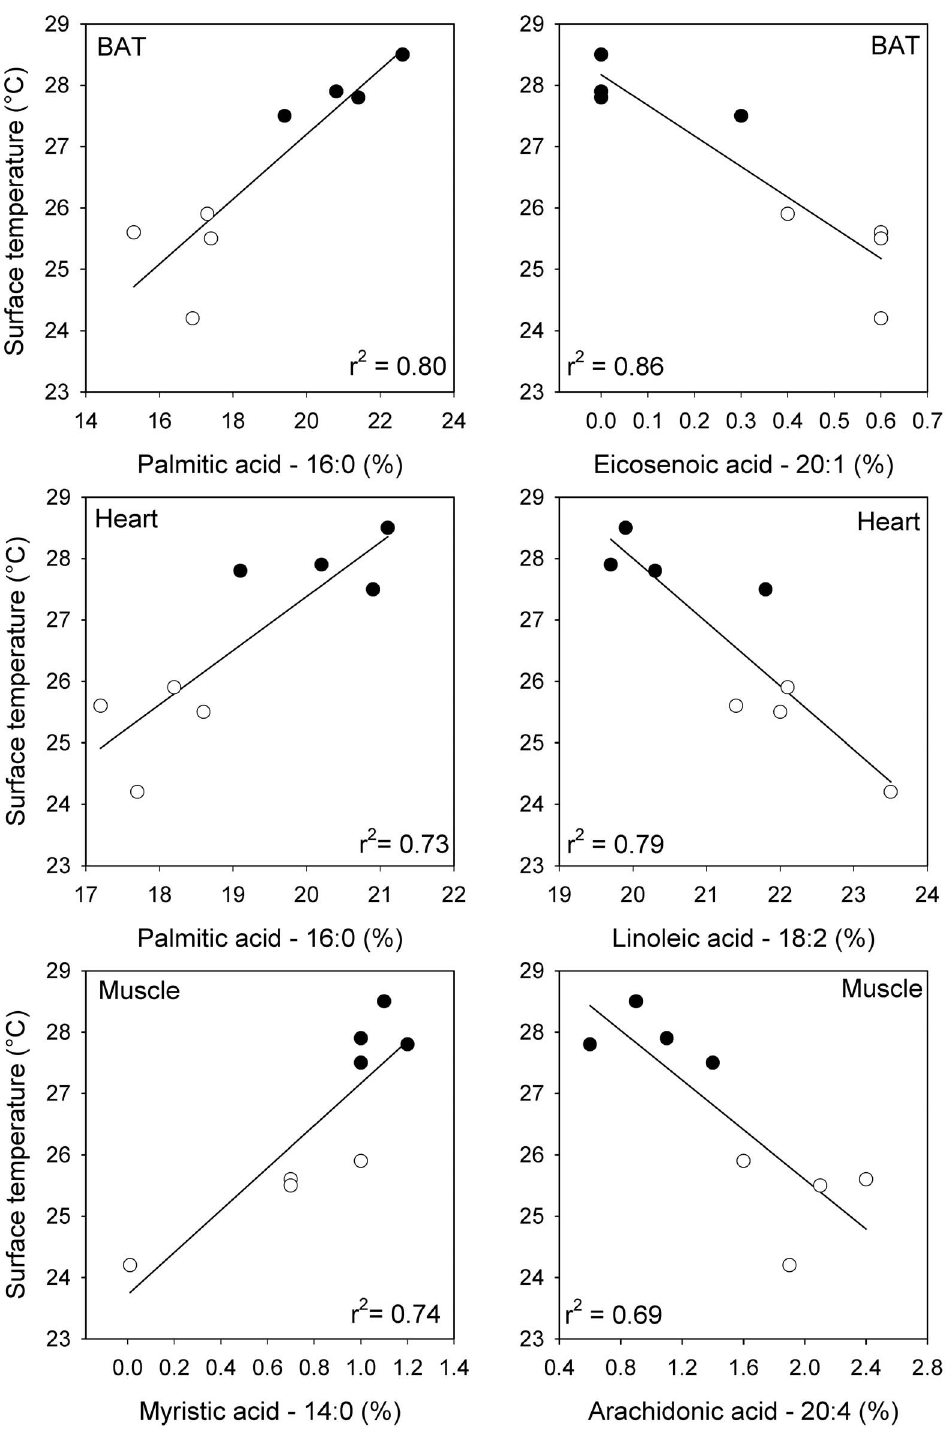
Figure 2. Linear regressions of mean surface temperature (T s ) of individual P.sungorus as a function of fatty acid percent. Equations are provided in Table 6 and the two regressions with the greatest r 2 –values for each tissue are shown. Black dots represent long photoperiod (LP) hamsters, circles represent short photoperiod (SP) hamsters. doi:10.1371/journal.pone.0063803.g002 Reproductive organs of male P. sungorus also changed enor- available detailing the adjustments in reproductive organs of mously with photoperiod acclimation. Testes and also epididimys females due to photoperiod acclimation in P. sungorus [32], but it mass in the SP group decreased by , 75% in comparison to the LP appears that, like for males, female reproductive organs change in group, similar to that previously documented [31]. Few data are mass and activity. In our study, the combined uterus and ovary